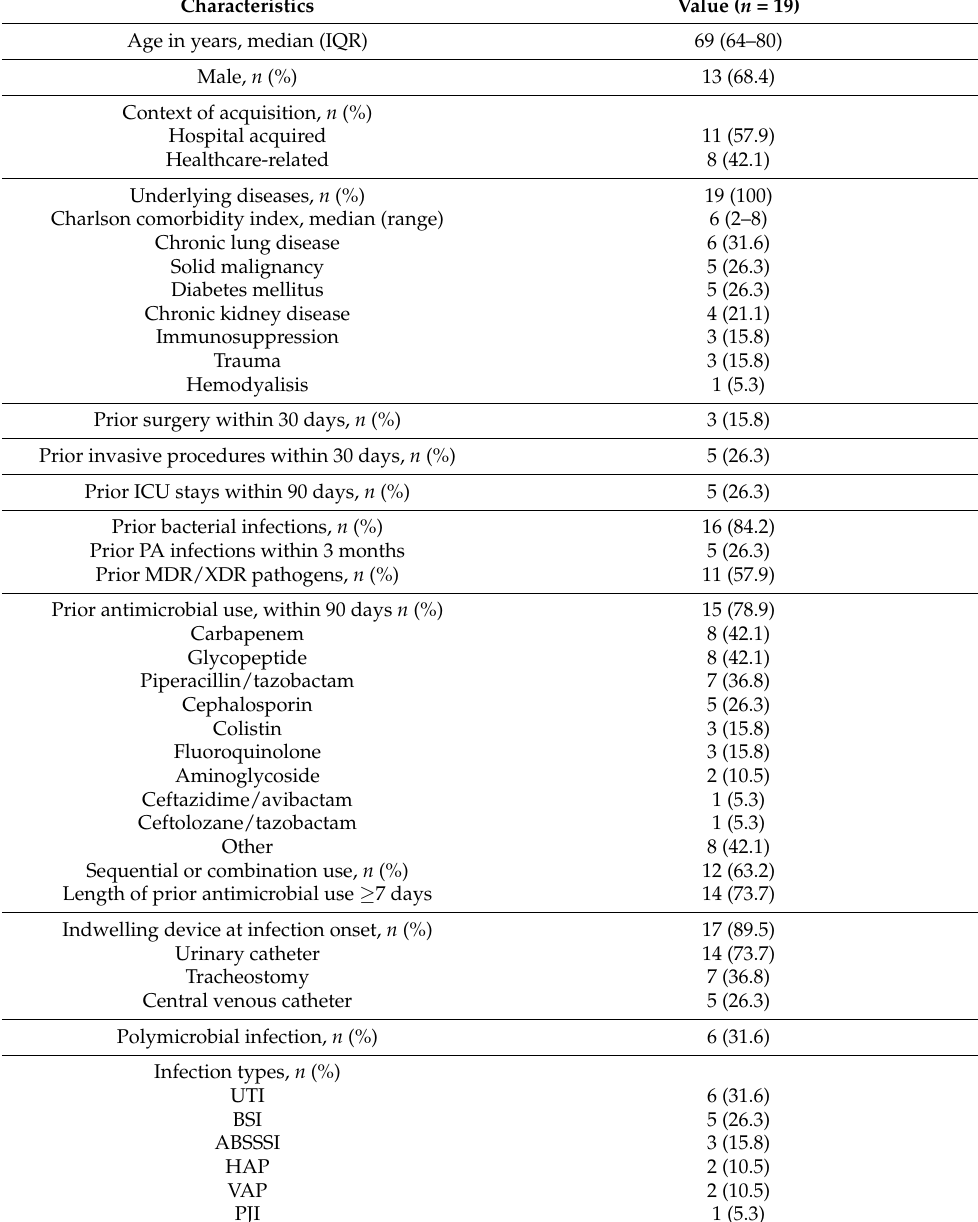
Table 1. Demographic and clinical